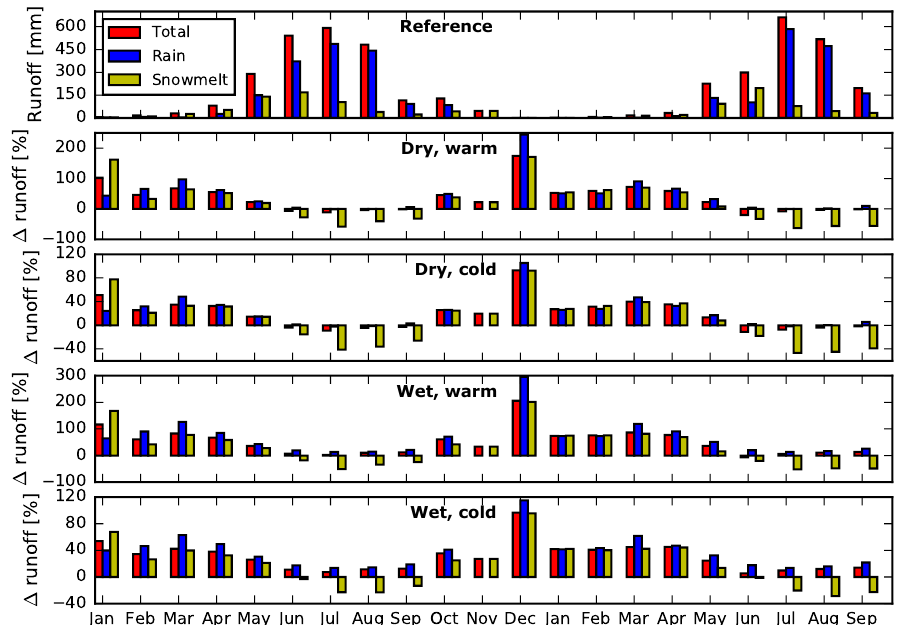
Figure 9. Modeled runoff at catchment outlet for the study period (January 2013–September 2014) and change in runoff compared to the study period for the climate sensitivity